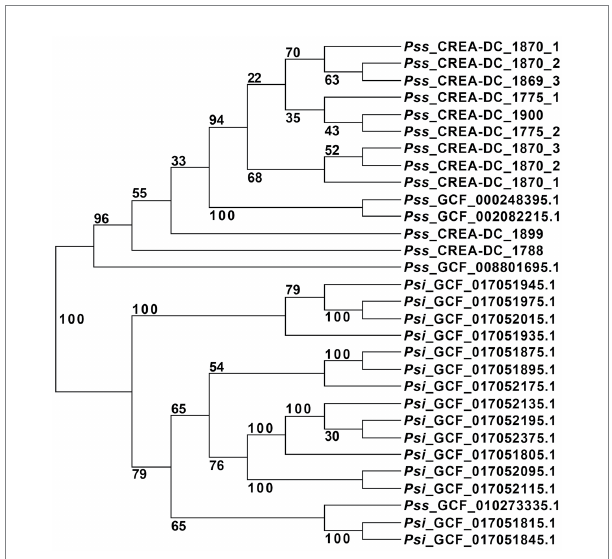
FIGURE 1 Unrooted phylogenetic tree of all Pantoea stewartii present at the NCI database, and the strains sequenced in this study with replicates. The strain GCF_002082215.1 was used as a reference for the alignment in RealPhy.